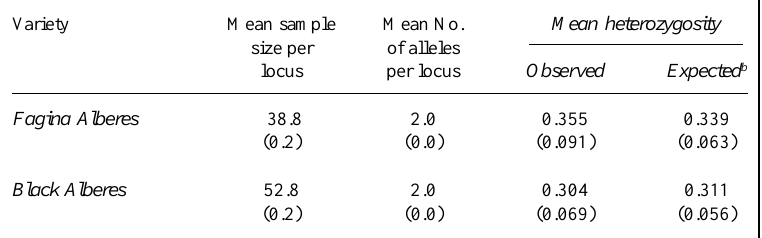
Table II - Statistics of genetic variability in the two varieties of “Alberes” cattle breed a . Variety Mean sample Mean No. Mean heterozygosity size per of alleles locus per locus